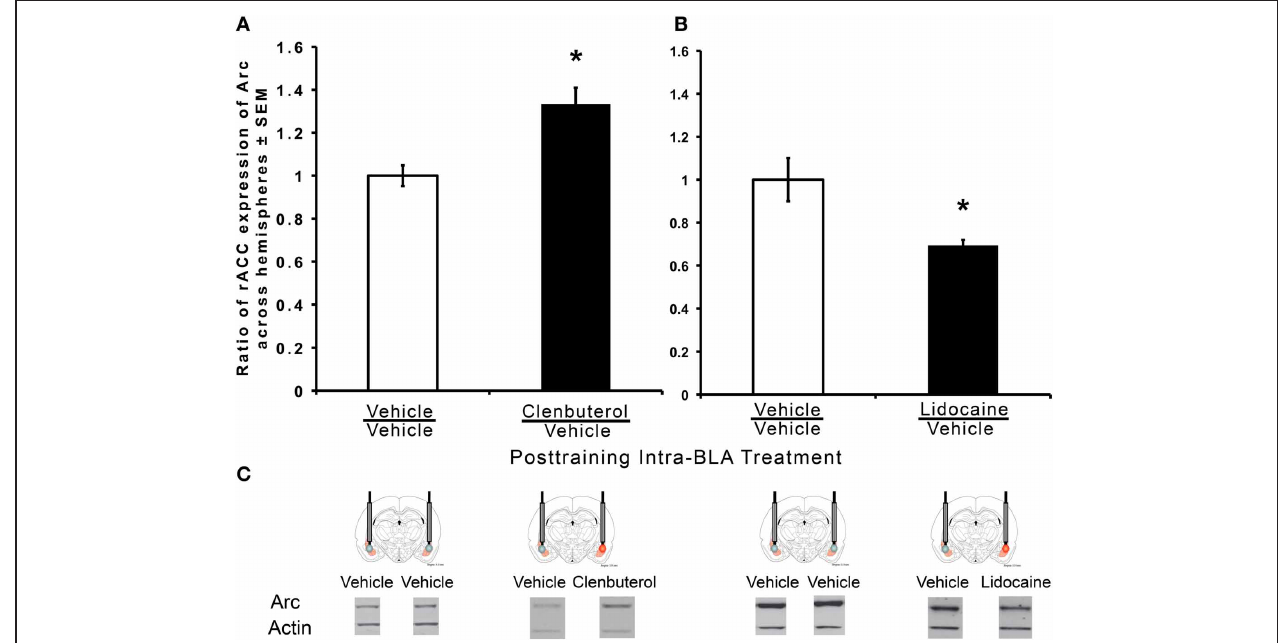
vehicle-infused animals ( m = 1 . 00 ± 0 . 05, n = 8). Values are expressed as percent to normalized cage control ratios. ∗ p < 0 . 01. (B) Significantly less Arc protein expression was measured in the rACC of rats treated with intra-BLA infusions of lidocaine immediately after training ( m = 0 . 69 ± 0 . 03, n = 5) compared to vehicle-treated animals ( m = 1 . 00 ± 0 . 10, n = 5). Values are expressed as percent to normalized cage control ratios. ∗ p < 0 .